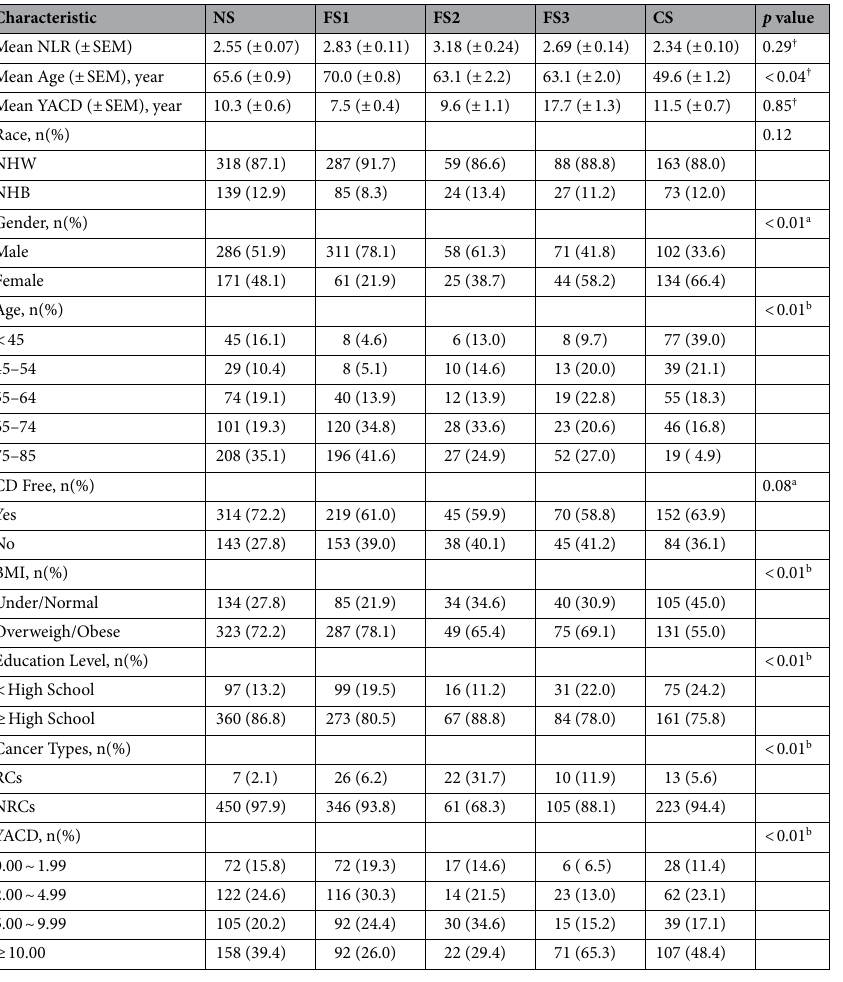
Table 2. Factors associated with smoking status in cancer survivors. † One-way ANOVA test found mean age is distributed differently between low-risk and high-risk NLR groups. a Rao-Scott Chi-square test. b Fisher’s exact test. SEM Standard error of the mean. NLR Neutrophil-to-lymphocyte ratio. CD Chronic diseases. BMI Body mass index. NHW Non-Hispanic White. NHB Non-Hispanic Black. NS Nonsmoker. FS1 Quit smoking 5 or more years before a cancer diagnosis. FS2 Quit smoking less than 5 years before a cancer diagnosis. FS3 quit smoking after a cancer diagnosis. CS Continued smoking after a cancer diagnosis. RCs Respiratory cancers. NRCs Non-respiratory cancers. YACD Years after a cancer